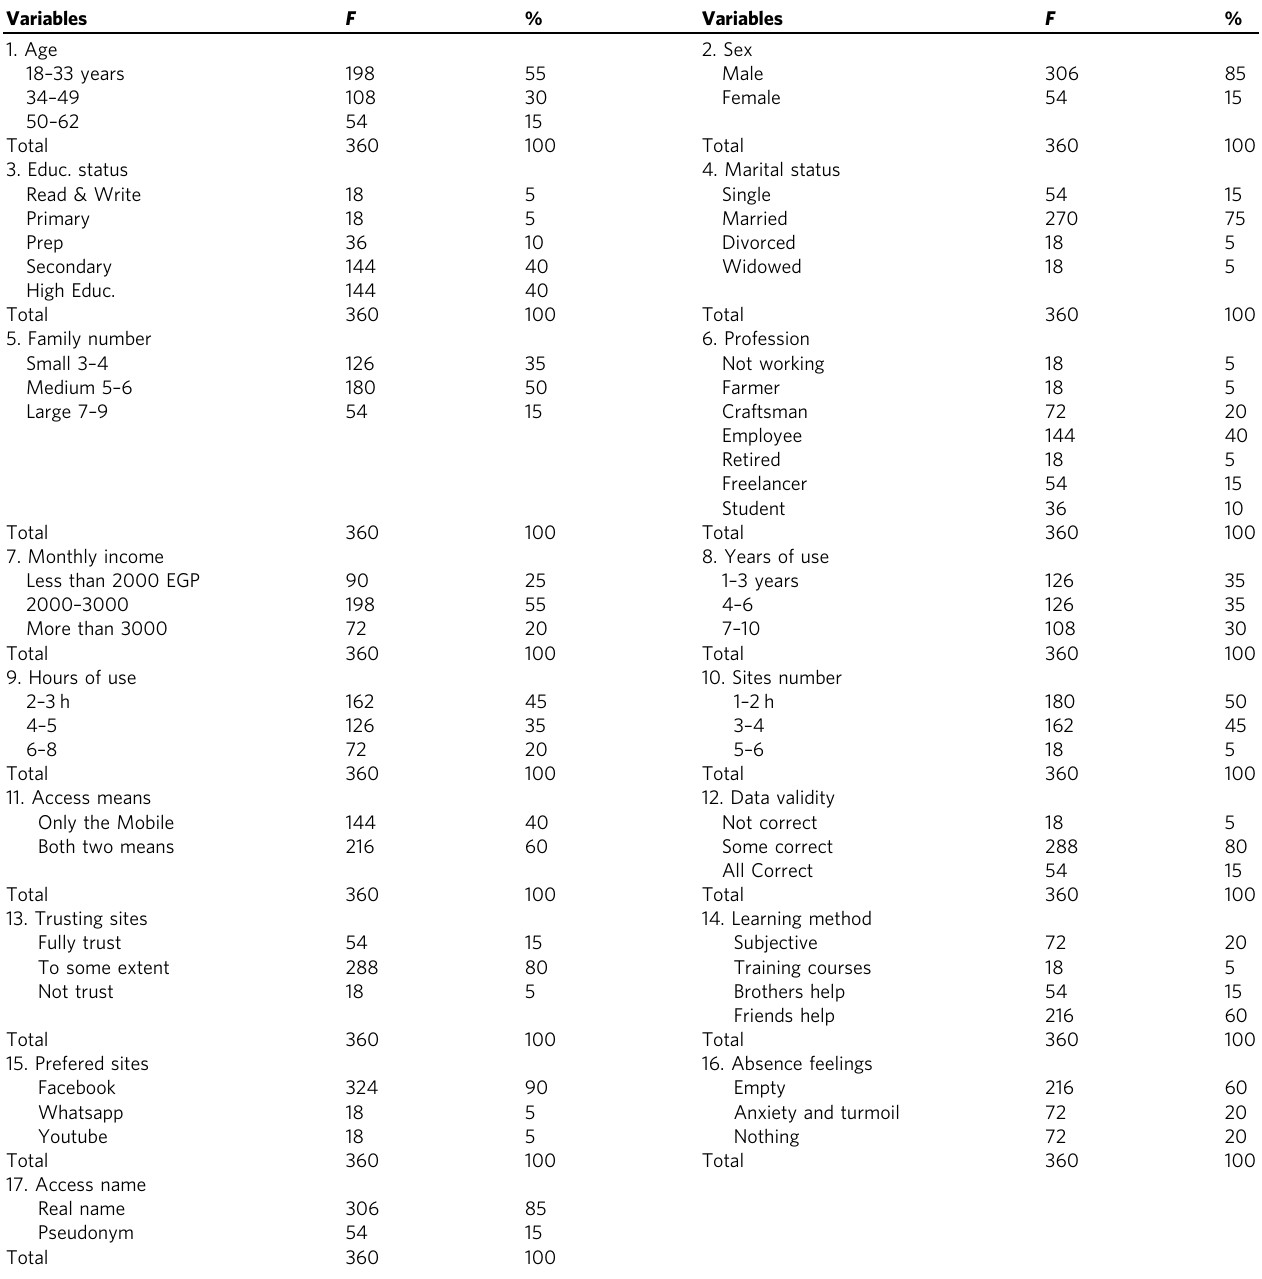
Table 1 Distribution of respondents according to their social, economic, and communication characteristics. Variables F %